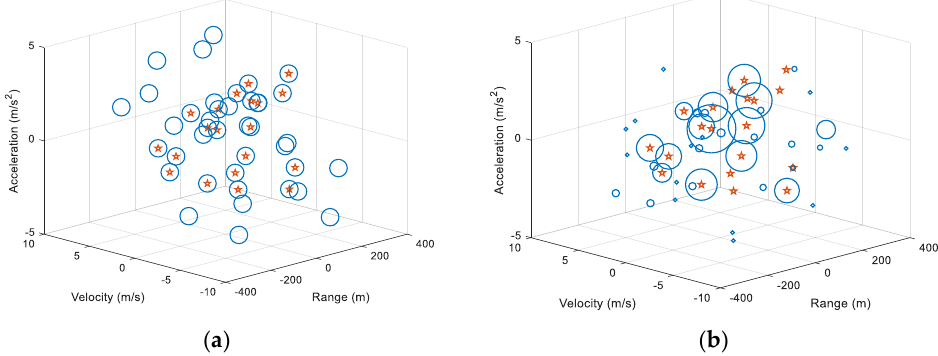
Figure 7. Speciation results of different niching methods in the GRFT search space, SNR = 15 dB: ( a ) BMMO and ( b ) BMMO-radius.